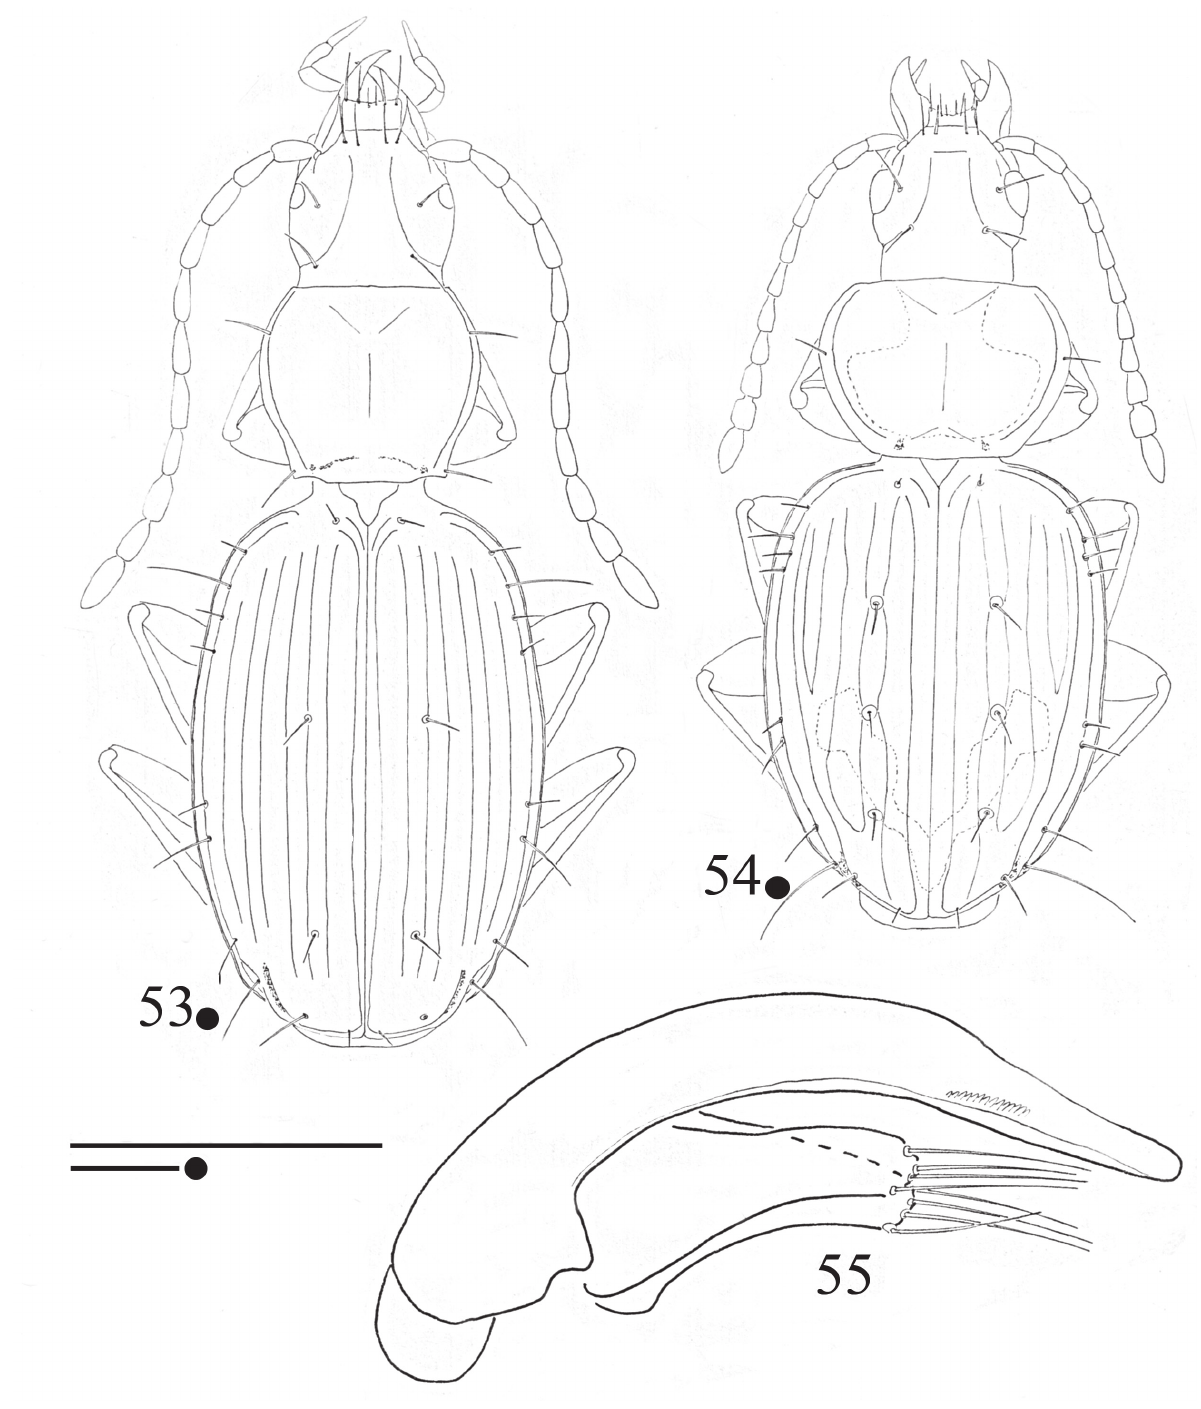
Figs 53-55. Habitus (53, 54) and aedeagus in lateral view (55) of: 53) Tasmanorites microphthalmus sp. nov., HT ♀ from Philrod Cave; 54, 55) Sloanella gordoni sp. nov., HT ♂ from Heritage Landing Walk. Scale: 0.2